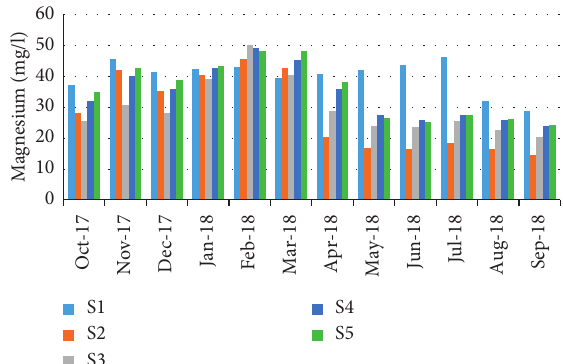
Figure 8: Spatial-temporal variation of chloride in the Zegzel watercourse.